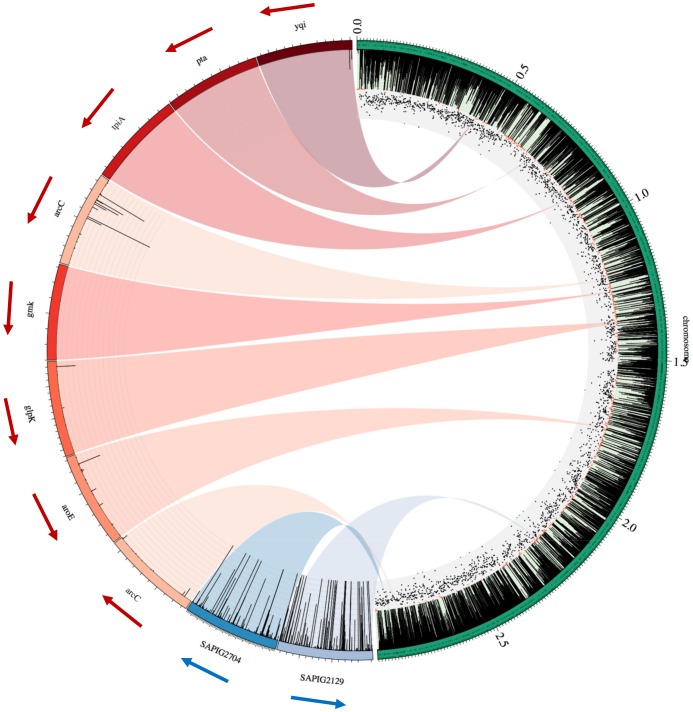
Genome atlas.Right semicircle: The green band in the outermost part of the semicircle illustrates the reference chromosome (AM990992) with the size of 2,872,582 bp. The three circular plasmids harboured by the reference are not included. The black spikes connected to the green semicircle shows the distribution of the reads from the raw transposon mutant library aligned to the reference strain. The black and red dots indicate positions within the reference with large number of reads (insertion index >0.02) and low number of reads (insertion index <0.02) respectively. Left semicircle: The red colours show of zoom of the seven MLST genes (arcC represented twice due to two copies of this particular gene) and the black spikes illustrated in some of the genes show reads mapping within the open reading frame. The arrows indicate transcription direction. The zoom of SAPIG2704 and SAPIG2129, visualised in blue colours, show examples of two genes with a large number of read mapping throughout the open reading frames.